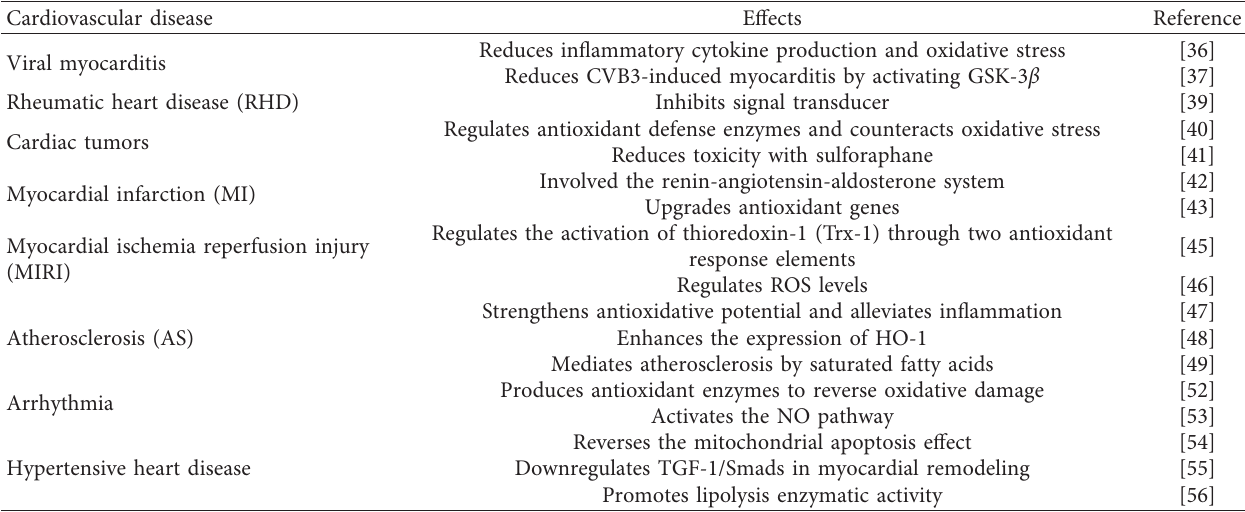
Table 1: Functional effects of the Nrf2/HO-1 signaling axis in cardiovascular diseases. Cardiovascular